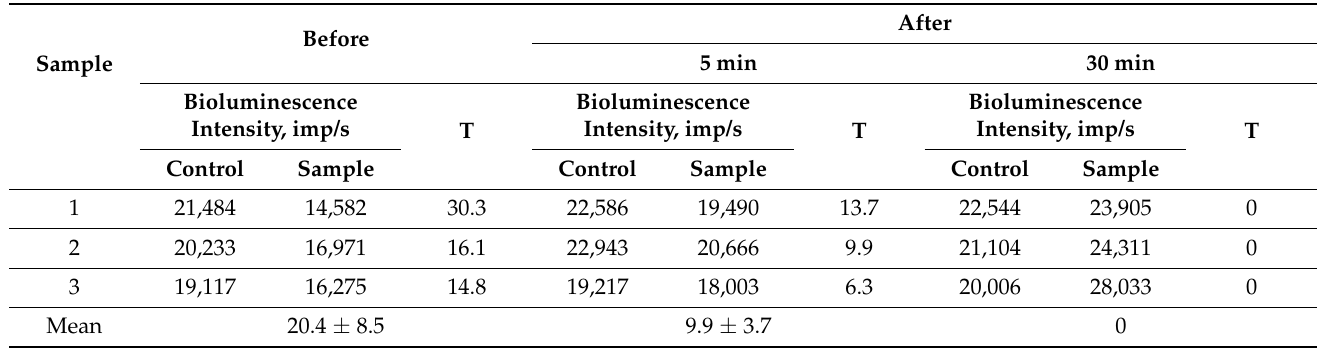
Table 3. The toxicity indices (T) of aqueous solutions before and after treatment in the UV/Fe 2+ /S 2 O 82 − system. [BPA] 0 = 43.8 µ M, [S 2 O 82 − ]:[BPA] = 5: 1, [Fe 2+ ] = 71.4 µ M, pH 0 = 5.7.